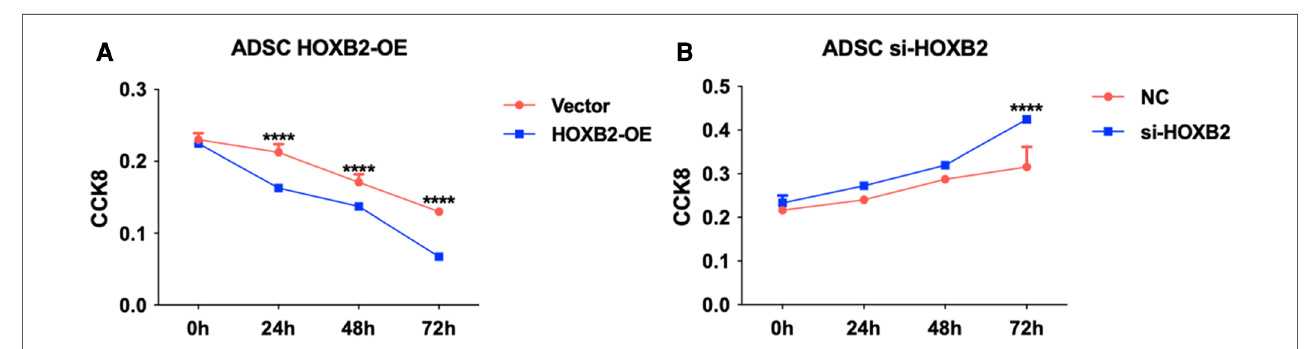
FIGURE 6 ( A ) HOXB2 overexpression inhibited ADSC proliferation. ( B ) HOXB2 knockdown increased the ADSC proliferation